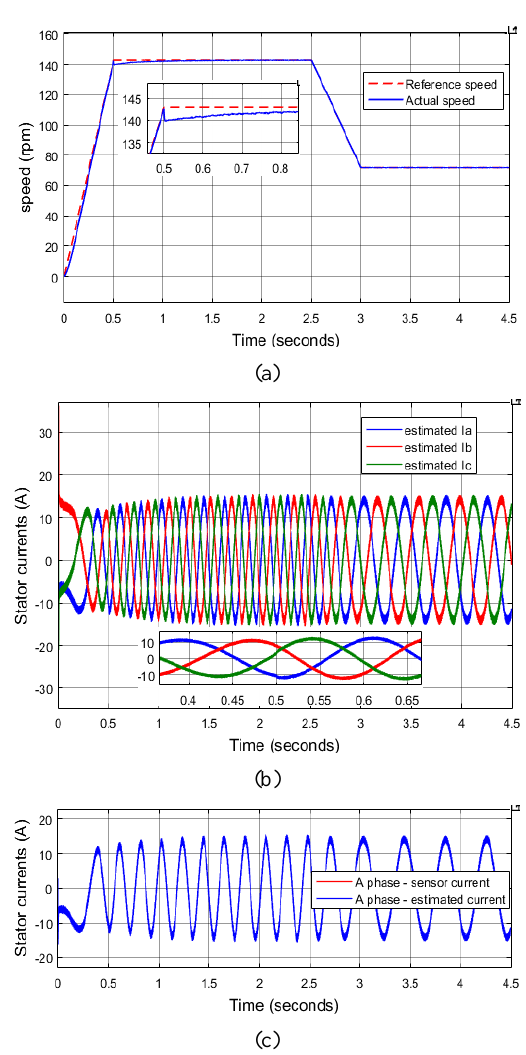
Fig. 10. Pulse load torque: amplitude 3 (N.m), period 0.5 s, pulse width 50%.